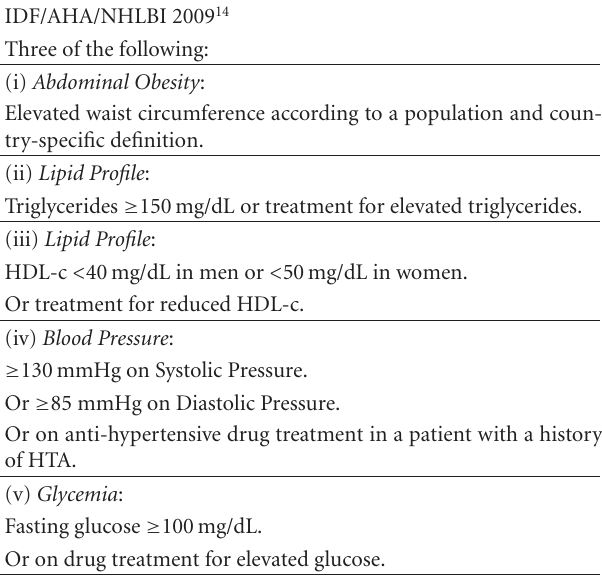
Table 1: Metabolic Syndrome criteria according to International Diabetes Federation/American Heart Association/National Insti- tutes of Health, Heart, Lung, Blood Institute,